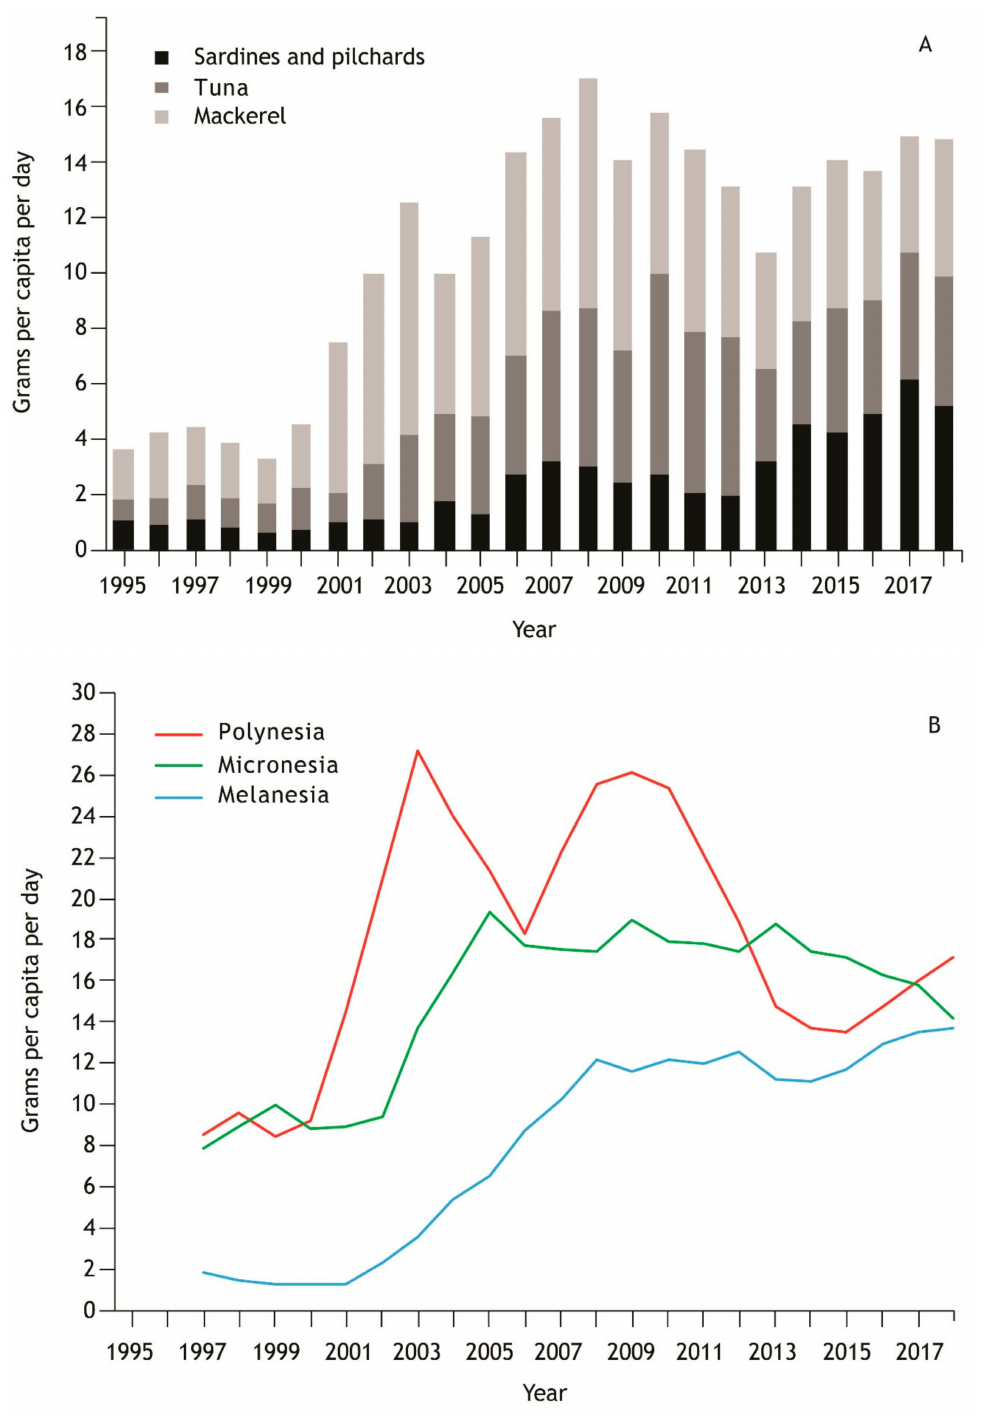
Figure 3. Per capita import (apparent consumption) of canned fish to 17 Pacific Island Countries and Territories (full list available in supplementary information, Papua New Guinea excluded because of its relative dominance in the data set) ncluding ( A ) regional trend by fish types and ( B ) total import by sub-region. Estimates exclude other minor quantities of canned fish including salmon and herring. Sub-regional trends are a 3-year moving average and include all canned fish types included in the regional estimate. Edible portions are likely to be 0.7 to 0.85 of the estimates shown due to inedible portions (e.g., brine, oil and cans) and variation in proportion of fish by total weight across di ff erent fish types and processing methods (see Table 1). Canned fish data from the Pacific Food Trade Database [66]. Human population data from UN Population division (https: // www.un.org / development / desa / pd /